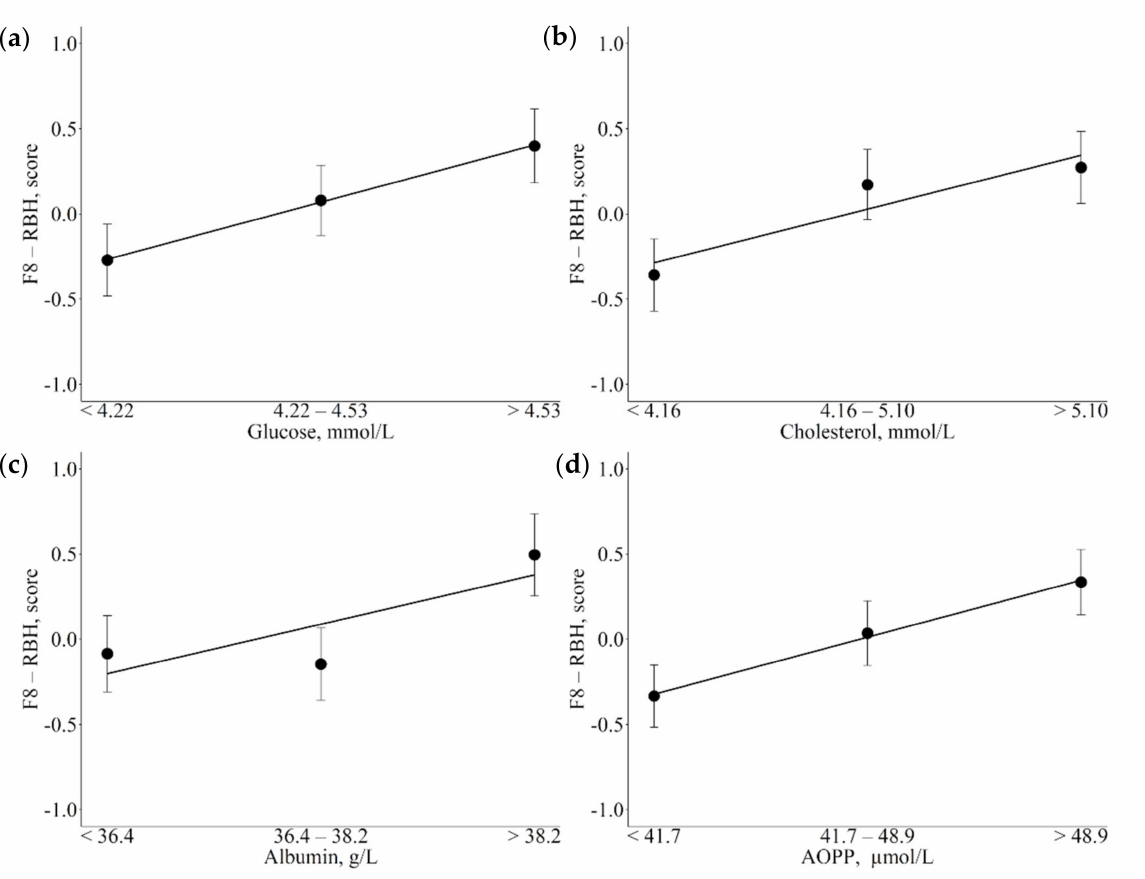
Figure 5. Least square means (LSM) for F8-rumen biohydrogenation (RBH) across the traits of concern. ( a ): glucose; ( b ): cholesterol; ( c ): albumin; ( d ): advanced oxidation protein products (AOPP). Black dots indicate the LSM and error bars indicate the standard error. Trendlines define linear or quadratic pattern according to polynomial contrast calculations ( p <